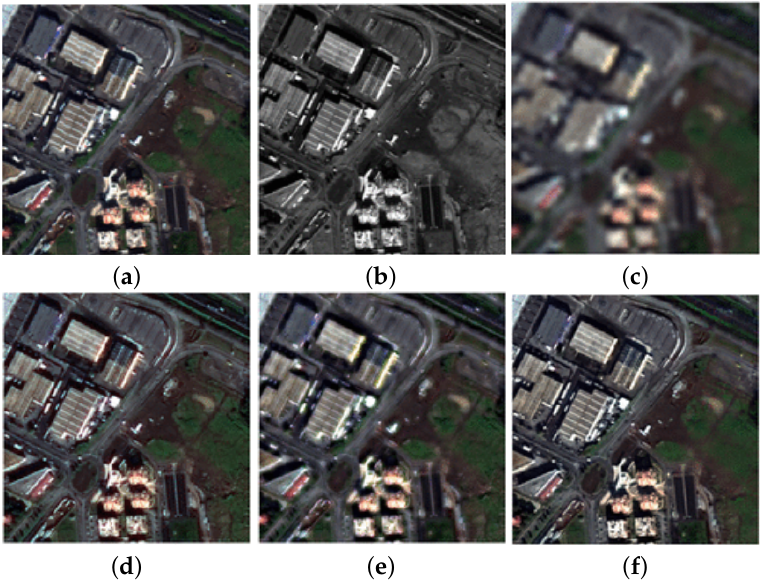
Figure 5. WorldView-II image results: ( a ) true-color composition of the original 4-m multispectral (MS) image, i.e., the reference data; ( b ) input 4-m Pan image; ( c ) input 16-m MS image; ( b , c ) are obtained by degrading the original Pan/MS resolutions by a factor of four; ( d ) AWLP; ( e ) Li algorithm; ( f ) super-resolution-based details injection (SR-D)